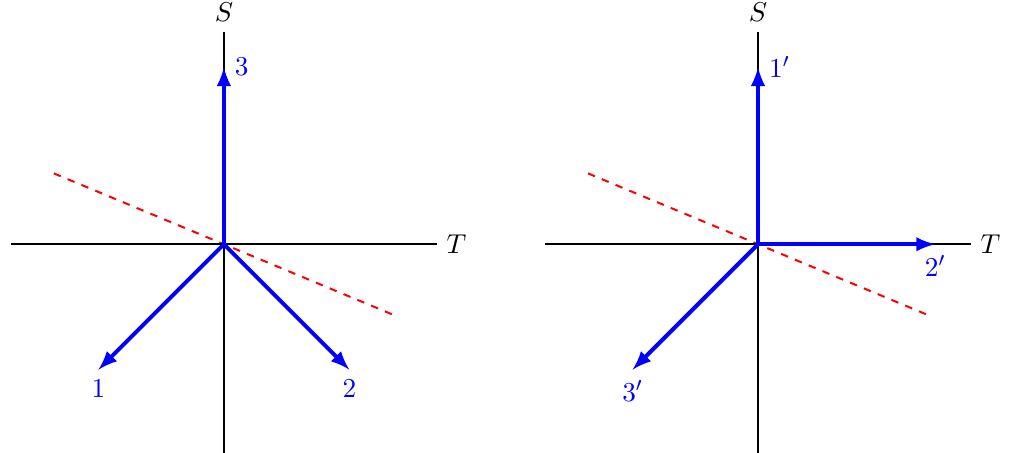
Figure 2. The normal fans of the Newton polytopes of 1 + ST + T 2 (left) and 1 + S 2 + 2 ST + T 2 (right). The rays are drawn in blue arrows; they are the inner normal vectors of the facets of Newton polytopes in figure 1. The cones are {{ 1 } , { 2 } , { 3 } , { 1 , 2 } , { 2 , 3 } , { 3 , 1 }} and {{ 1 0 } , { 2 0 } , { 3 0 } , { 1 0 , 2 0 } , { 2 0 , 3 0 } , { 3 0 , 1 0 }} respectively. The fan on the left is isomorphic to the fan on the right by the flip along the red dashed line, the line at an angle − π/ 8 with the T